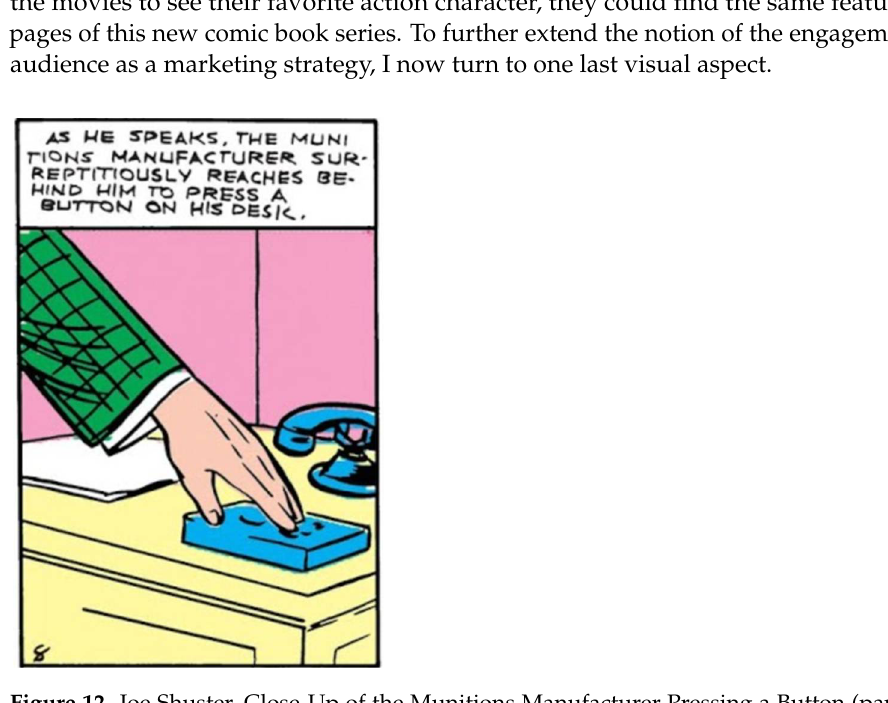
Figure 12. Joe Shuster, Close-Up of the Munitions Manufacturer Pressing a Button (panel No. 8), 1938. Siegel and Shuster (July 1938), “Superman”, Action Comics #2 (Siegel and Shuster 1938b, p. 23). © DC Comics.